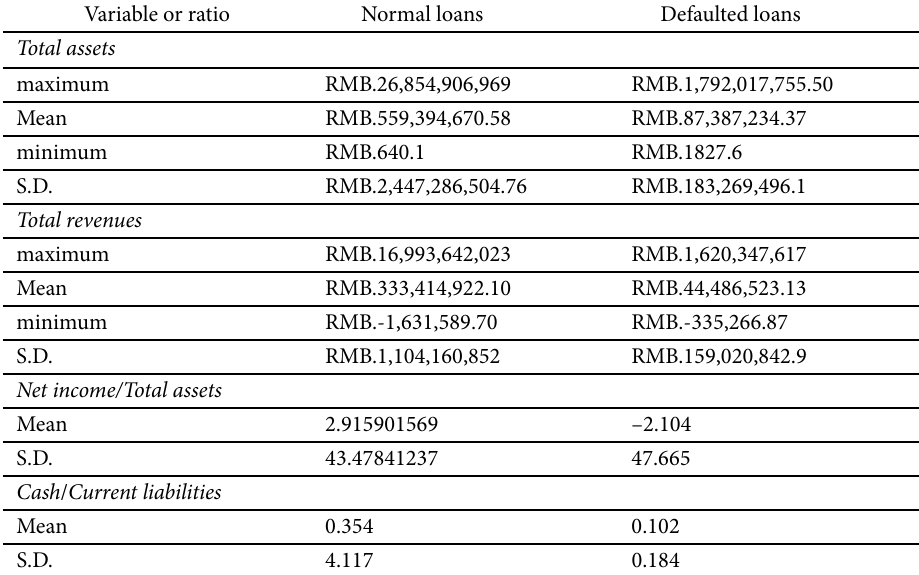
Table 1. Comparison of subsample characteristics Variable or ratio normal loans Defaulted